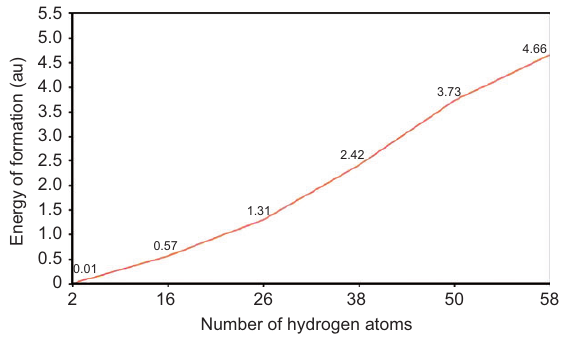
Figure 1 Energy of formation for endohedral fullerenes with